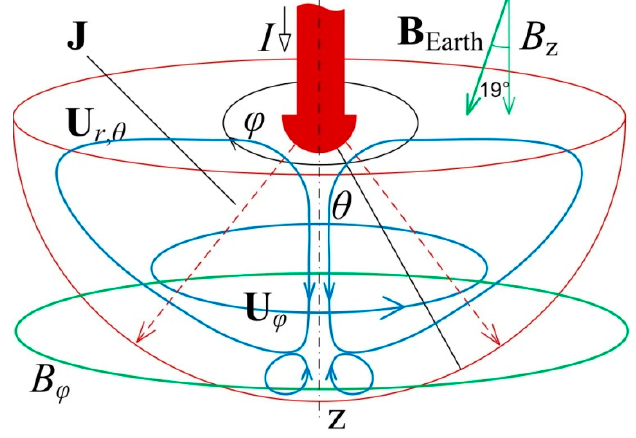
Figure 1. Scheme of the electrovortex flow.